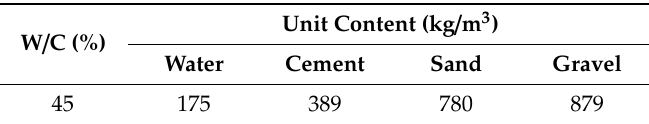
Table 1. Mixing proportions of the